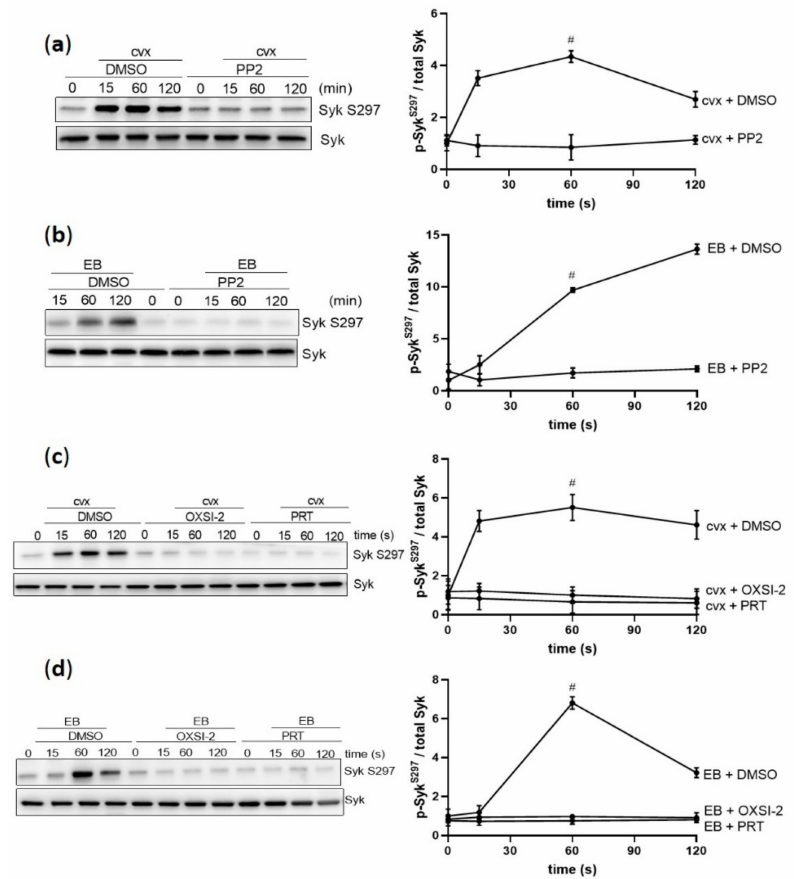
Figure 3. Cvx-and EB-mediated Syk S297 upregulation is dependent on SFKs and Syk activation. Washed human platelets were pre-incubated with vehicle control (DMSO) or with the SFK inhibitor PP2 (10 µ M) for 5 min at 37 ◦ C prior to stimulation, under stirring conditions with ( a ) 50 ng / mL cvx or ( b ) 0.5% ( v / v ) EB or with two di ff erent Syk inhibitors, OXSI-2 (2 µ M) and PRT-060318 (1 µ M) for 5 min at 37 ◦ C prior to stimulation with ( c ) cvx or ( d ) EB. Phosphorylation of Syk S297 was analyzed by immunoblotting compared to total Syk. Data are represented as means ± SD from three independent experiments with platelets from three healthy donors. # p < 0.0001, DMSO versus inhibitor-treated (PP2, OXSI-2, or PRT-060318) platelets at 1 min in response to cvx or